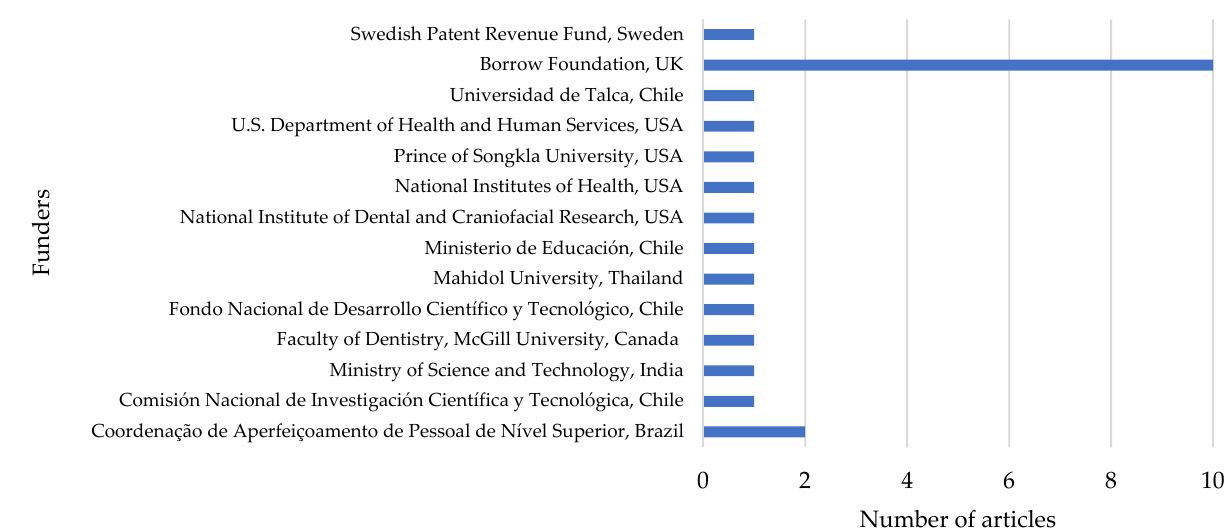
Figure 5. Funders of original research on milk fluoridation.